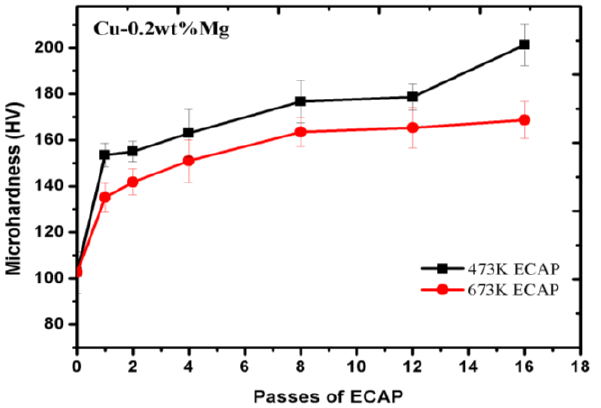
Figure 5. Microhardness of Cu-0.2wt%Mg alloy variation with the passes of ECAP at 473 K and 673